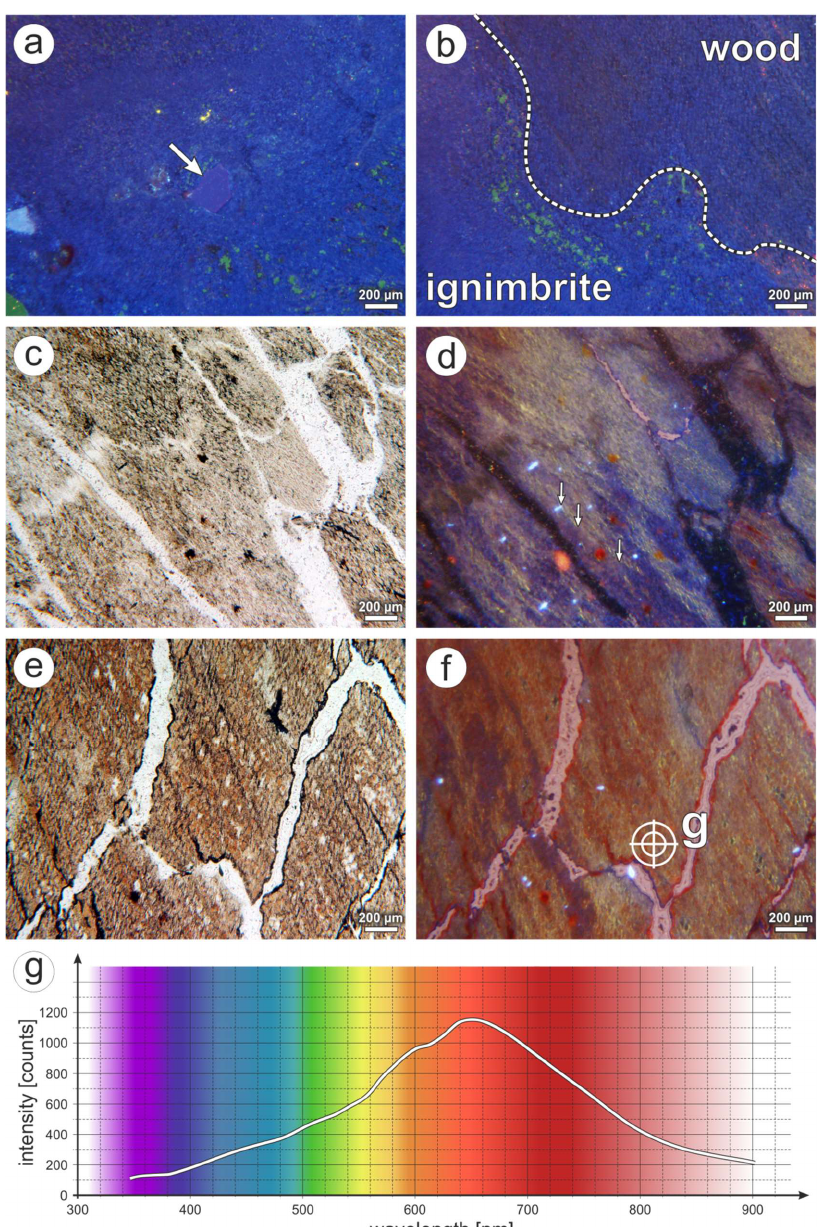
Figure 7. CL of K6562. ( a ) CL image of the ignimbrite showing short-lived blue CL of the matrix and a quartz grain (arrow). ( b ) Same view as in 8e; CL image. Note identical CL of both wood in zone 1 and ignimbrite. ( c ) Transition of zone 1 and 2 PPL image. ( d ) Same view as in (c); CL image. Yellow CL is restricted to areas distant to fractures (arrows). ( e ) Zone 2; PPL image. ( f ) Same view as in (e); CL image. Note that blue CL has been replaced by red CL in the cell lumina. Fractures are filled by red-luminescent cryptocrystalline silica. ( g ) CL spectrum taken at (f).